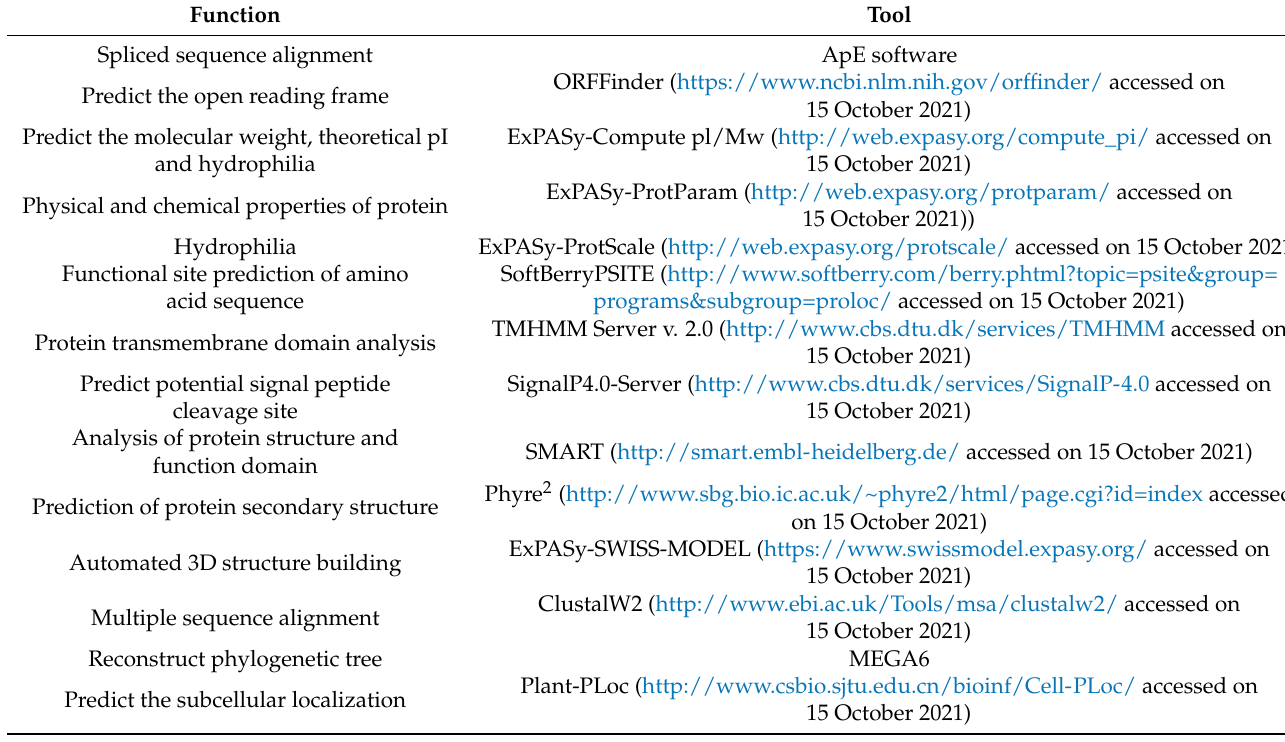
Table 3. Methods and the website of bioinformatics